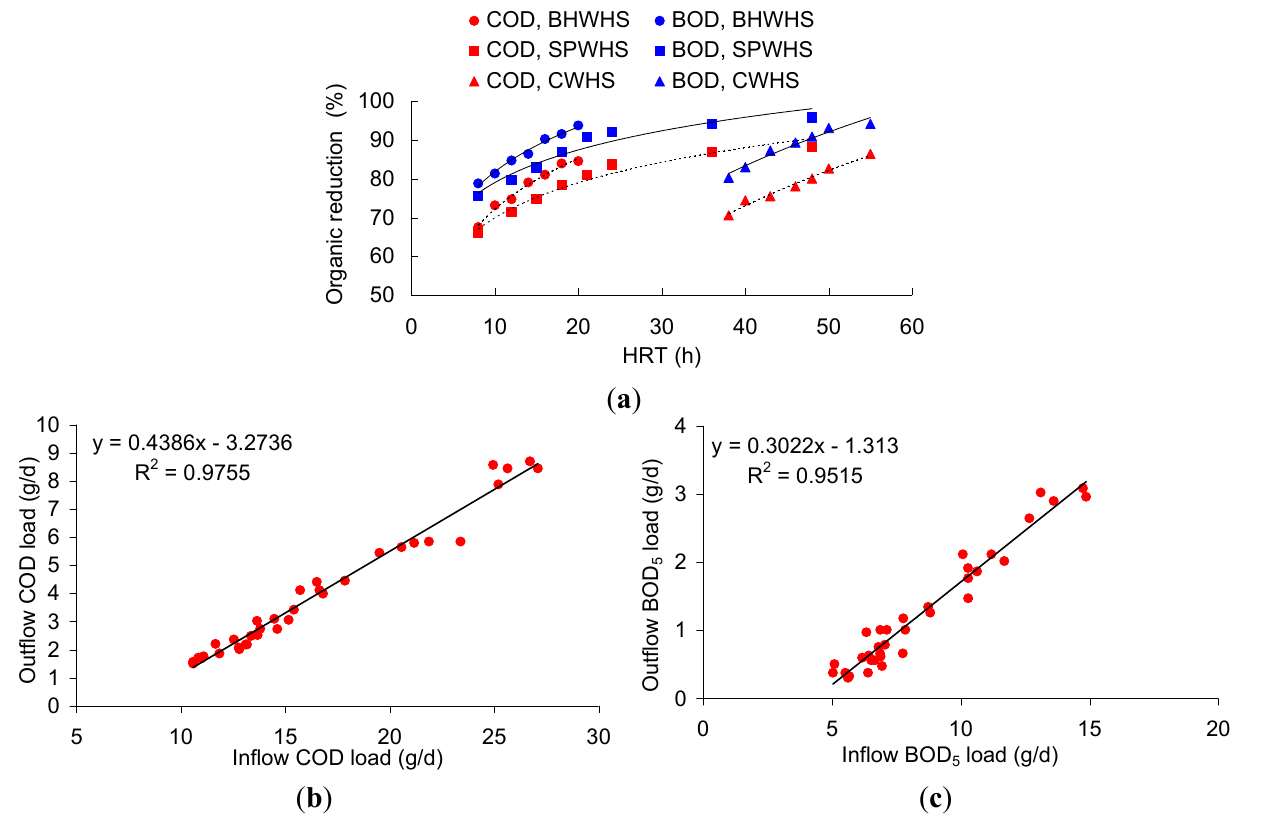
Figure 2. ( a ) Mean reduction of the COD and BOD 5 values in the water hyacinth treatment systems ( n = 5) (COD value represents the mean of daily sample of 10 consecutive days merely in SPWHS); Relationship between the inflow and outflow COD ( b ) and BOD 5 ( c ) loadings under steady-state operation in the Bio-hedge system. BHWHS: bio-hedge water hyacinth system, SPWHS: shallow pond water hyacinth system [16];